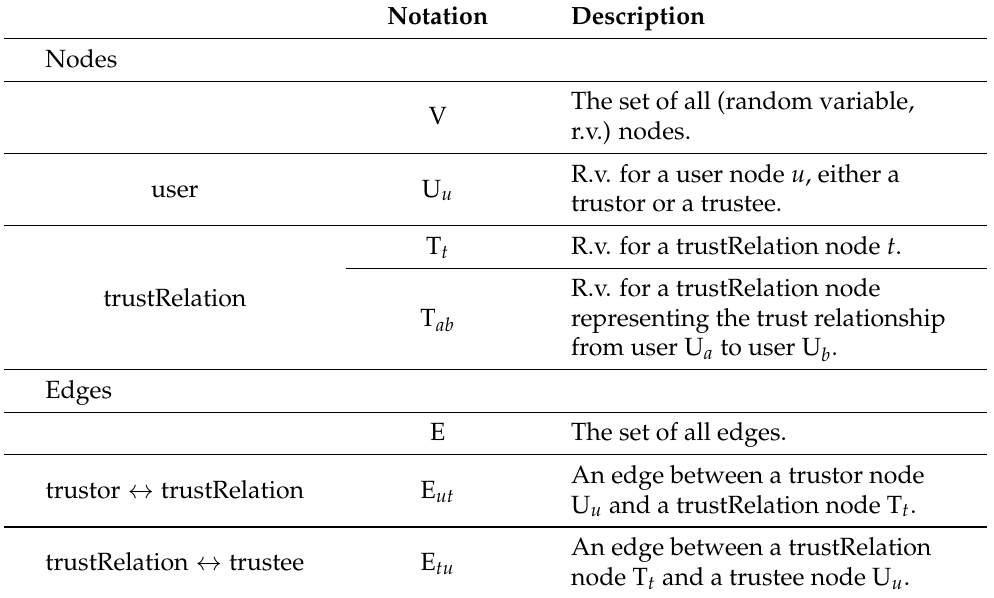
Table 1. Notation of (random variable) nodes and edges in the proposed